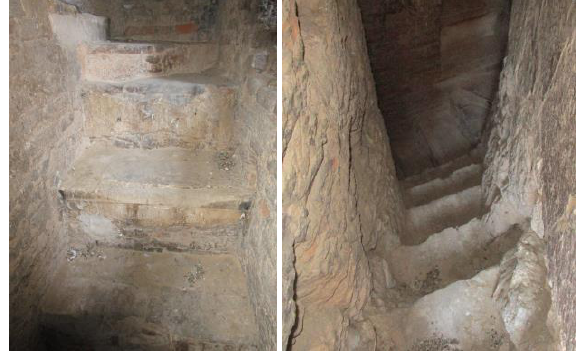
Figure 3. Brick square box staircase with stone screed in the access to the space immediately bellow the cover of the